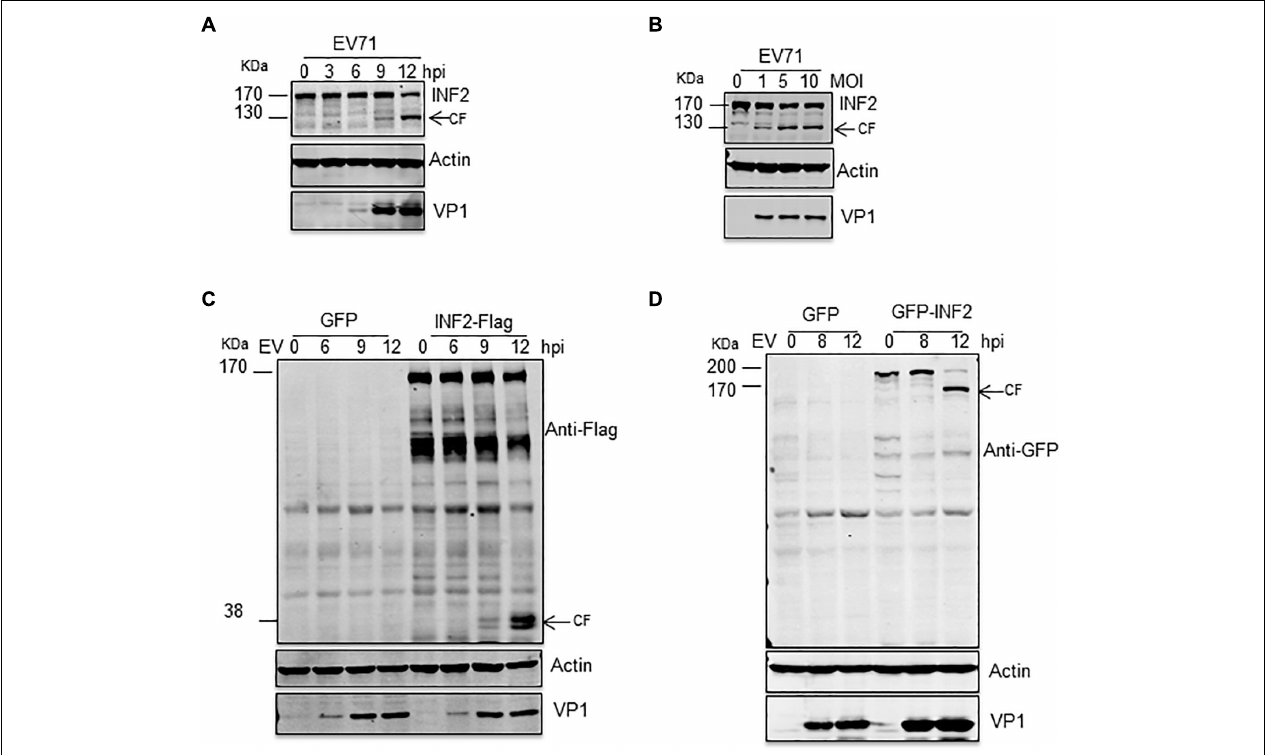
FIGURE 1 | EV71 induces INF2 cleavage in infected cells. (A) RD cells were infected with EV71 (MOI = 10) for the indicated times (hpi, h post-infection), and (B) RD cells were infected with the suggested dosage of EV71. The cells were then harvested, and Western blotting was performed using the indicated antibodies to detect INF2, EV71 VP1, and Actin. Arrows indicate the cleavage fragments (CF). (C,D) RD cells were transfected with plasmids encoding GFP control/INF2-Flag (C) or GFP control/GFP-INF2 (D) , 24 h after transfection, the cells were infected with EV71 (MOI = 10) for the indicated times (hpi, h post-infection), and then the cells were harvested, and Western blot was performed using the indicated antibodies. Arrows indicate the cleavage fragments